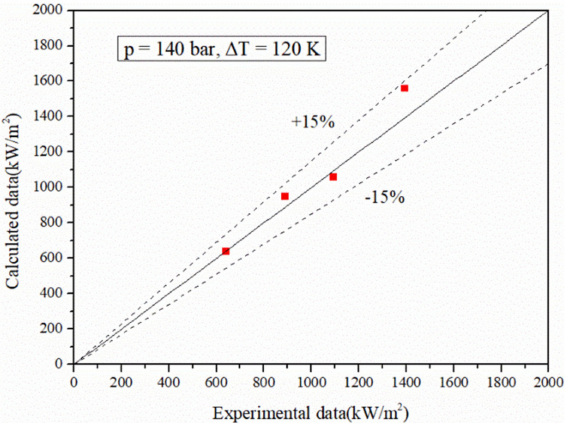
Figure 9. Comparison of calculated and experimental